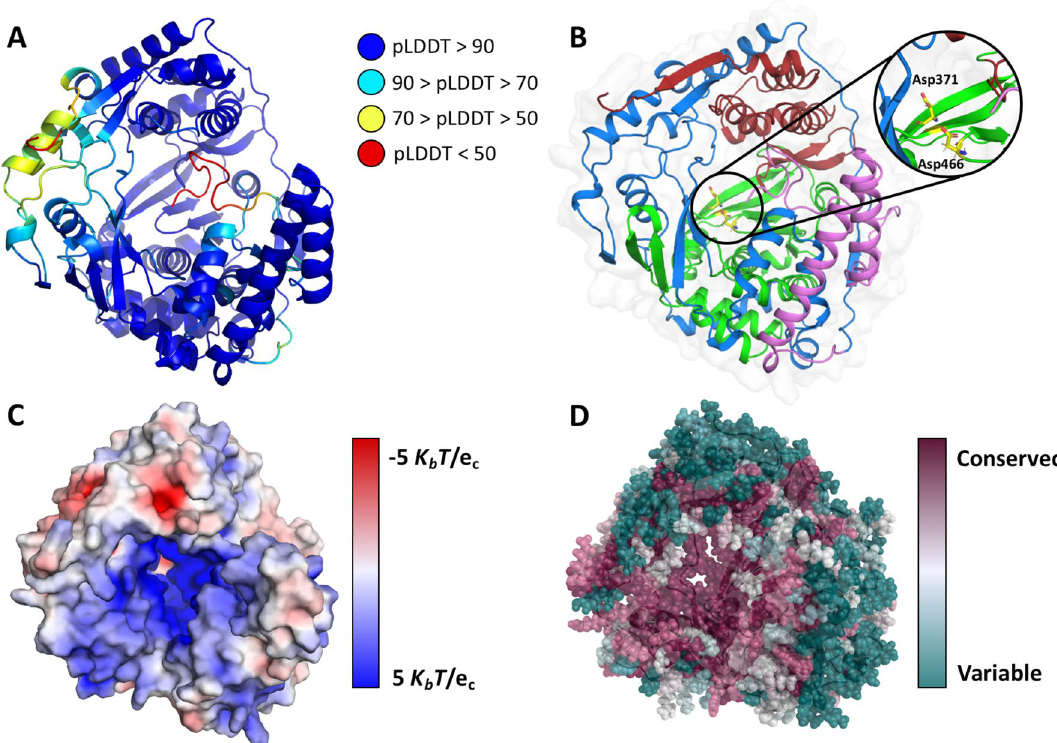
Figure 3. nsP4-CHIKV three-dimensional model by AlphaFold. ( A ) nsP4-CHIKV AlphaFold model colored according to pLDDT. At the top right are shown the pLDDT color scales. ( B ) Model of nsP4-CHIKV colored according to domain assignment. The N-terminal helixes, finger, palm and thumb domains are colored in purple, dark blue, green and red, respectively. A detailed view of predicted catalytic aspartic residues is presented in the inset. ( C ) Electrostatic potential projected on the surface charge of nsP4-CHIKV, calculated with APBS. Positive regions are colored in blue and negative regions are in red. ( D ) ConSurf analysis of nsP4-CHIKV model. The amino acids are colored by their conservation grades using the color-coding bar, with green-through-purple indicating